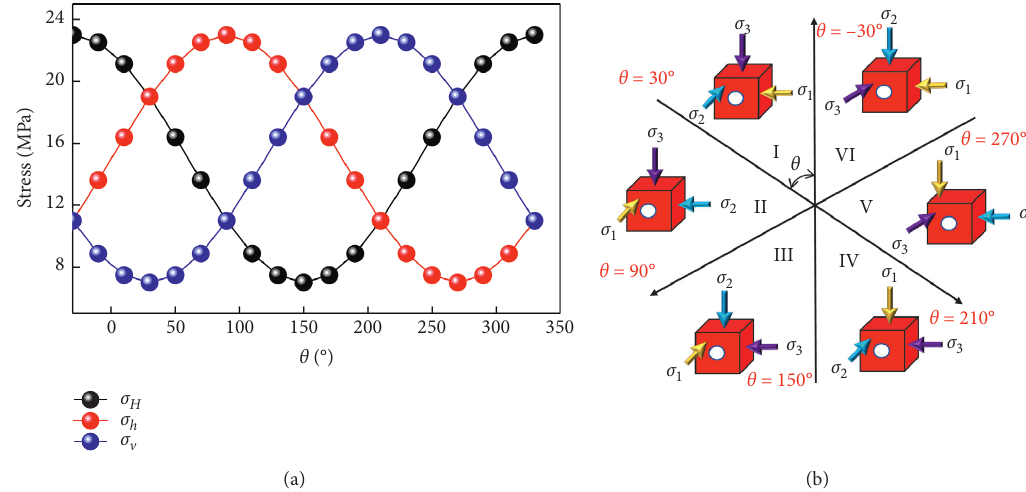
Figure 1: Stress loading and principal stress spatial distribution. (a) Relationship between principal stress and stress lode angle. (b) Stress state distribution